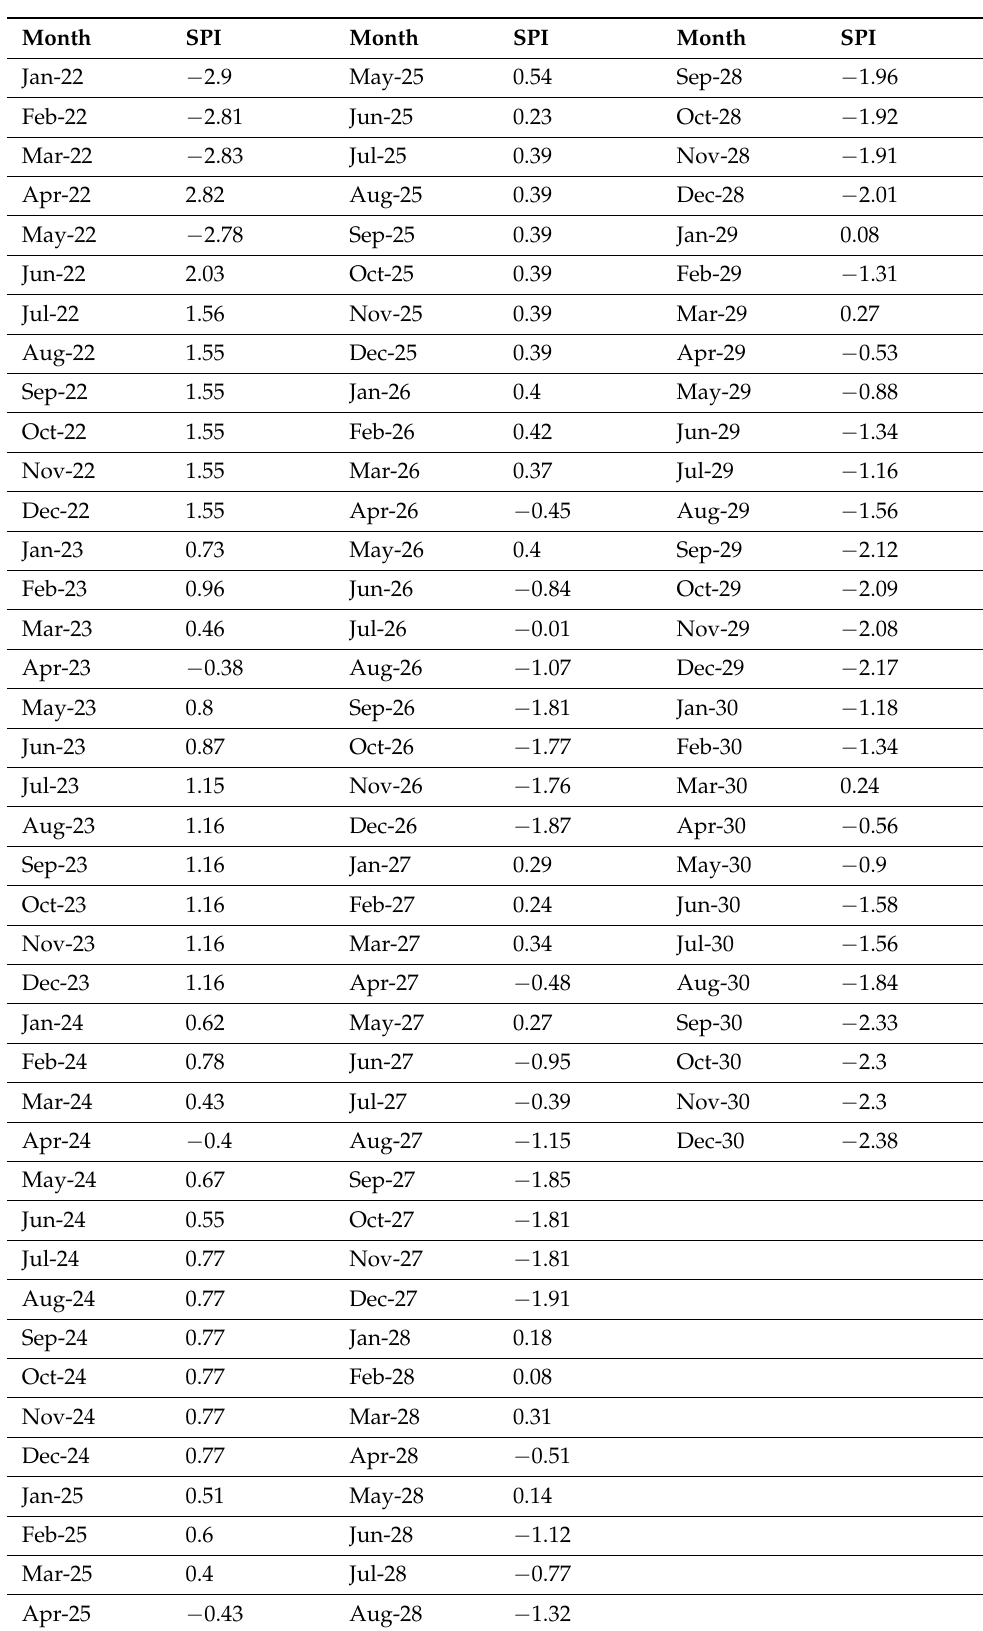
Table 4. SPI prediction from 2022 to